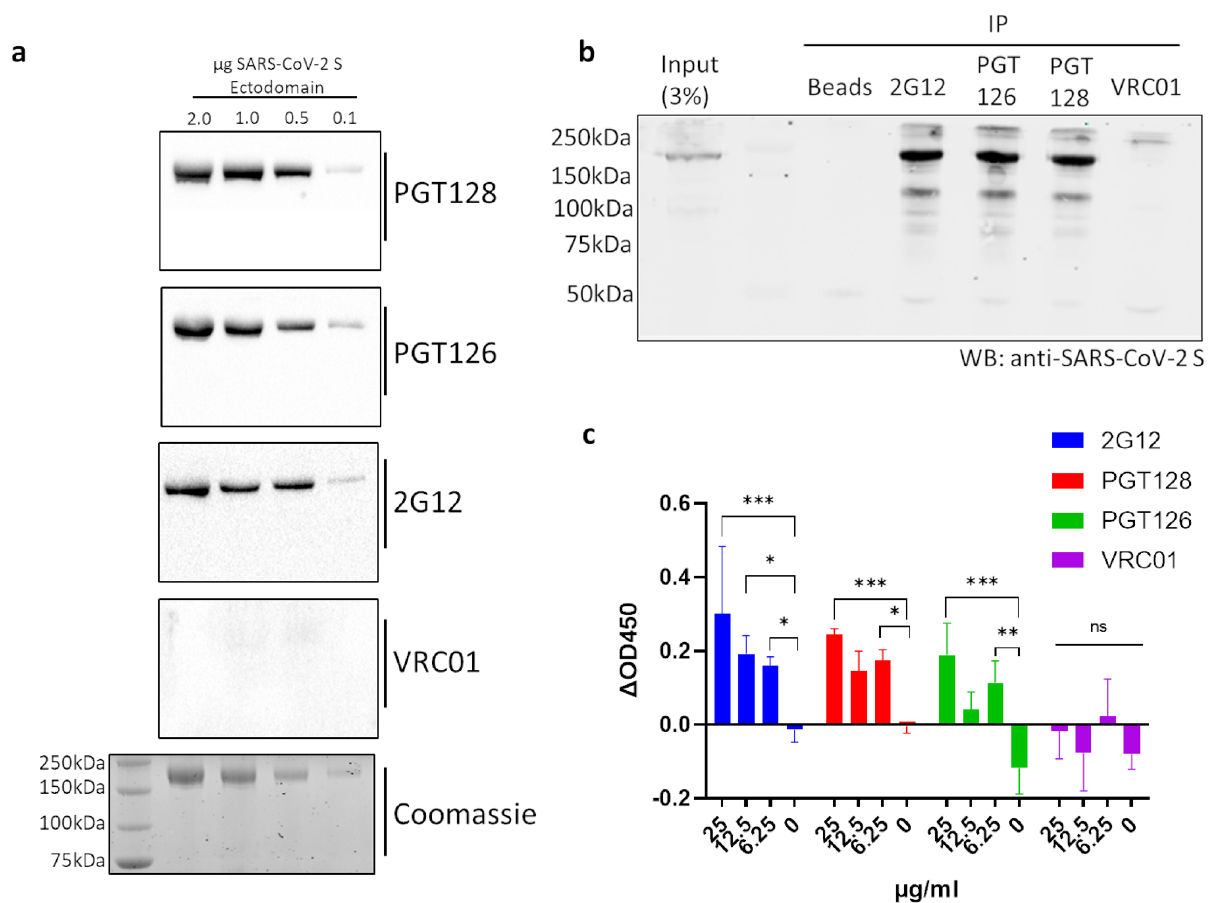
Figure 3. SARS-CoV-2 S binding capabilities of selected cross-reactive anti-gp120 antibodies. ( a ) Immunoreactivity of selected anti-gp120 antibodies with the SARS-CoV-2 S ectodomain was assessed via western blot, membranes were probed with the indicated antibodies prior to detection via HRP-anti-human IgG. A Coomassie-stained gel is included as a loading control. See Fig. S4 in supplementary information for uncropped gel images. ( b ) Immunoprecipitation (IP) of full-length SARS-CoV-2 S by selected anti-gp120 antibodies. Lysates generated from HEK293T cells transiently expressing full-length SARS-CoV-2 S were incubated with the indicated antibodies and subjected to immunoprecipitation using protein A beads prior to Western blot (WB) analysis with a commercially available antibody targeting SARS-CoV-2 S. An immunoprecipitation condition using protein A beads alone is included as a control. Shown is a representative blot from 2 independent experiments. See Fig. S5 in supplementary information for uncropped gel images. ( c ) Cell-based ELISA of cell-associated full-length SARS-CoV-2 S binding by the indicated anti-gp120 antibodies. Assays were carried out on chemically fixed HEK293T cells either transfected with plasmid encoding full-length SARS-CoV-2 S, or empty plasmid (mock). The difference in signal between these conditions is presented. Experiments were done in triplicate; error bars indicate standard deviation (n = 3). Statistical significance was tested by two-way ANOVA with Dunnett post-test ( P > 0.05 [ns, not significant], * P ≤ 0.05, ** P ≤ 0.01, *** P ≤